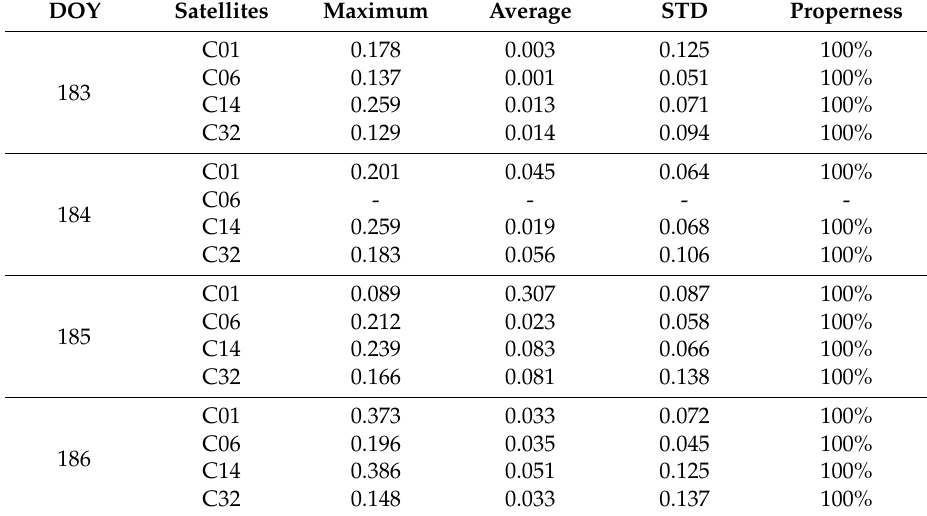
Table 3. The fractional parts of the estimated B 2 observations for C01, C06, C14 (BDS-2), and B 3 for C32 (BDS-3) on LHA1 (cycle).